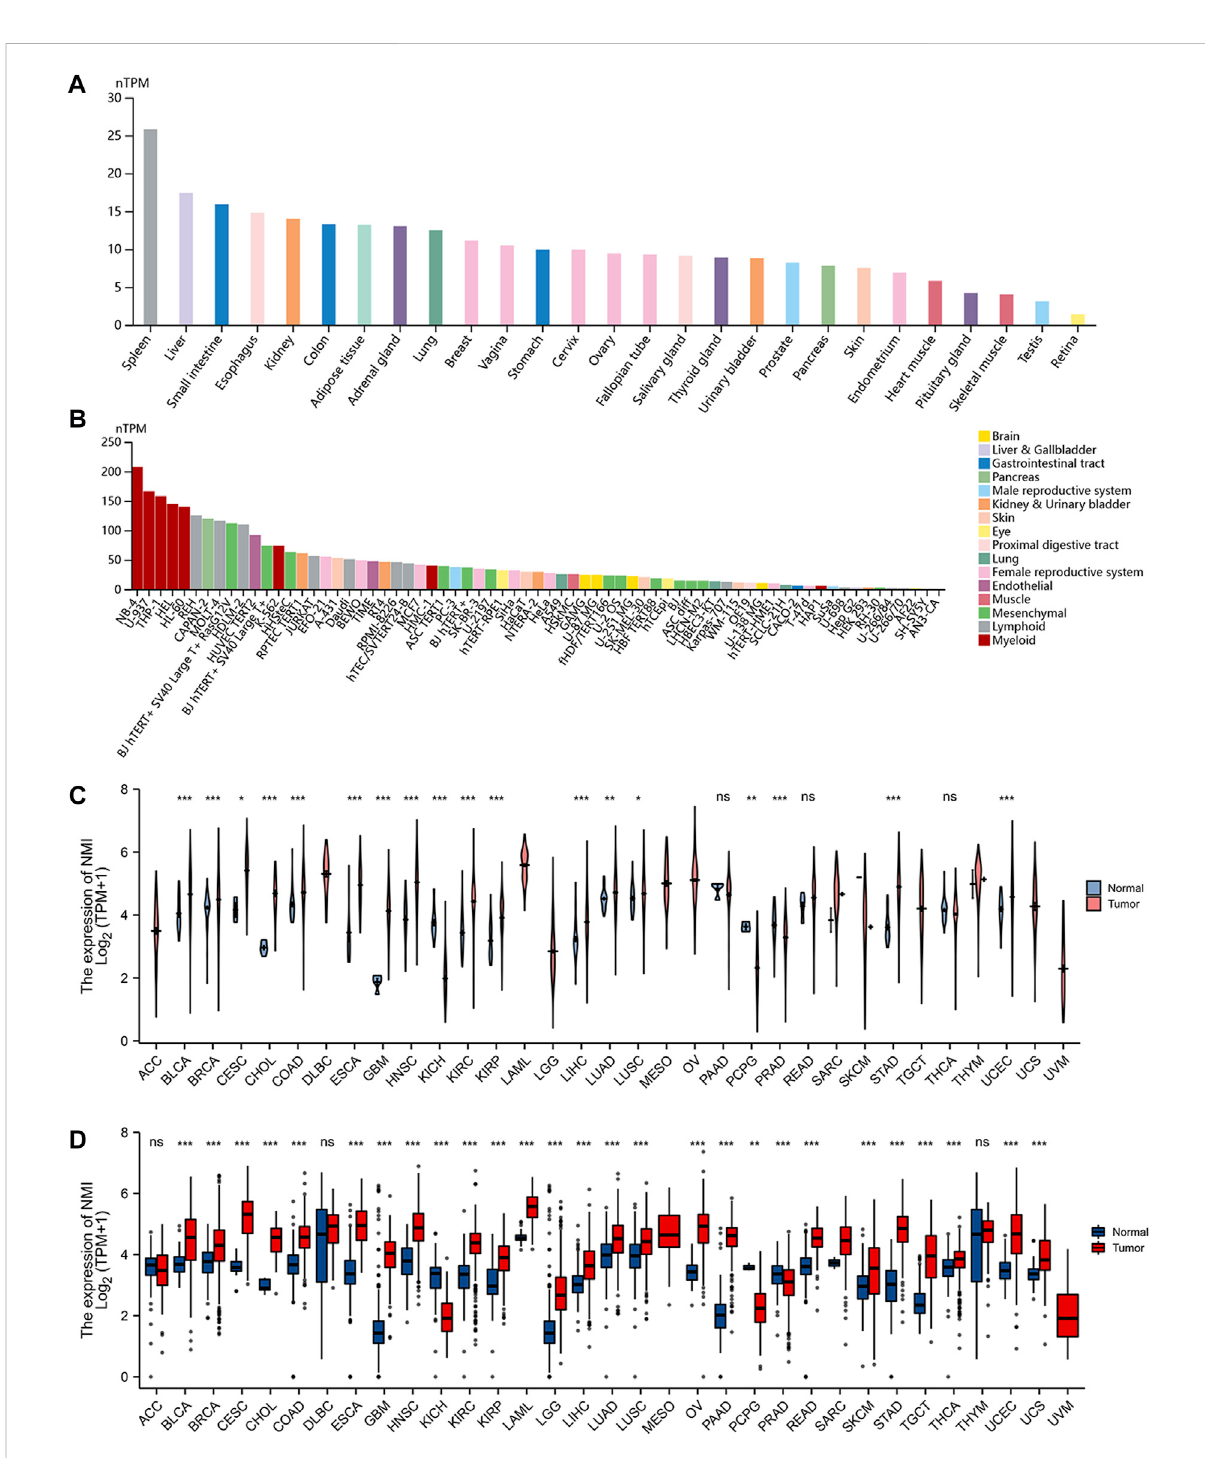
FIGURE 1 Expression level of NMI mRNA in pan-cancer. (A) NMI expression in normal tissues from GTEx database. (B) NMI expression in tumor cell lines from the HPA database. (C) Expression of NMI in tumor tissues and adjacent normal tissues from TCGA database. Pink represents tumor tissue and bluerepresentsadjacent normaltissue. (D) Expression ofNMIintumortissues andnormaltissues inGTExdatabase.Redrepresentstumortissue and blue represents adjacent normal tissue. * p < 0.05, ** p < 0.01, *** p < 0.001. ns, not signi fi